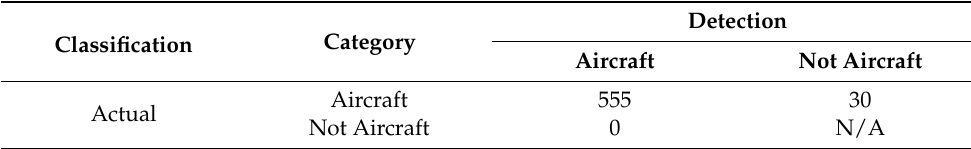
Table 3. Confusion matrix of